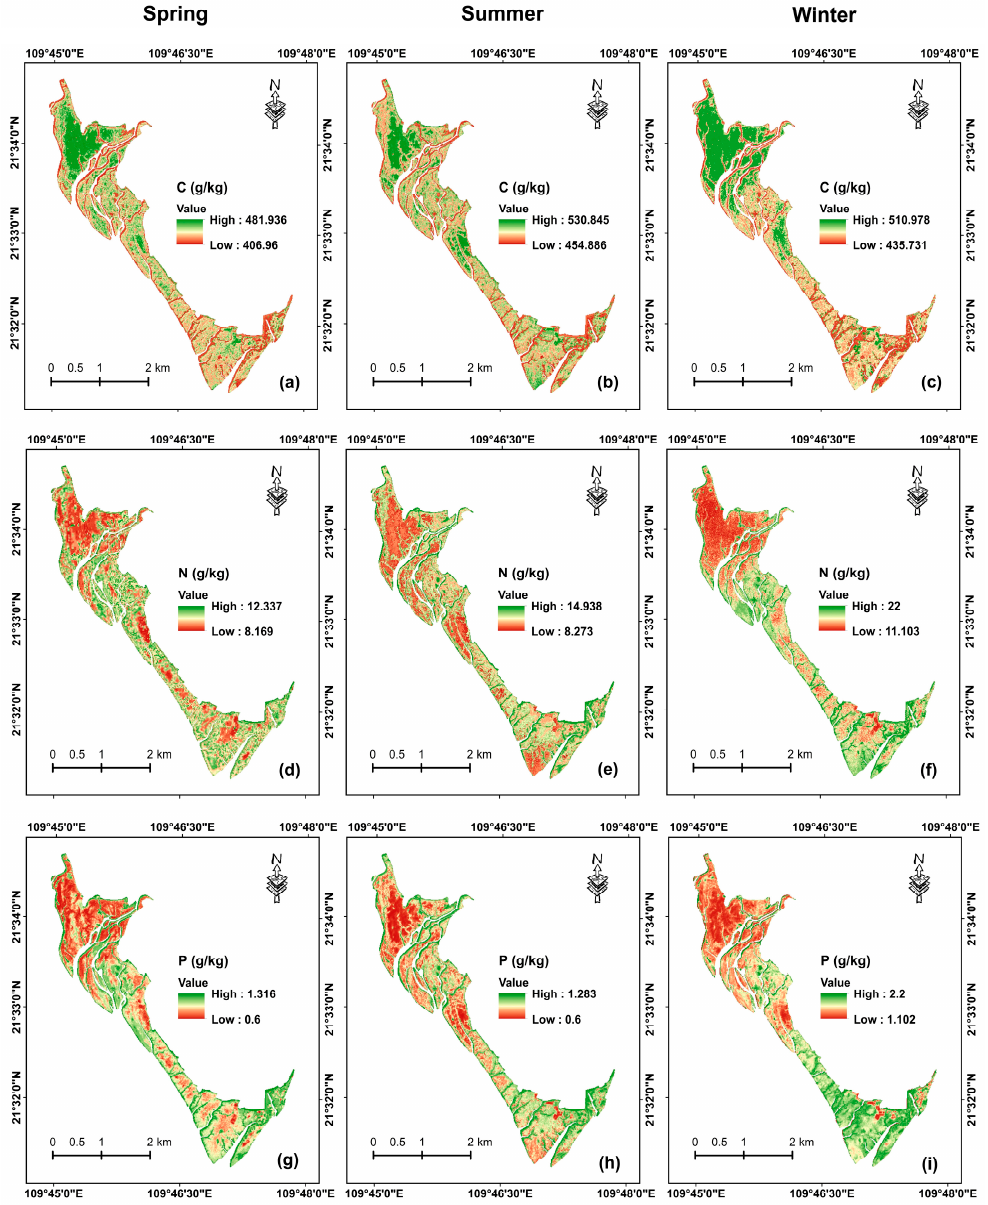
Figure 6. Maps of leaf C ( a – c ), N ( d – f ), and P ( g – i ) concentrations in spring, summer, and winter derived from the XGBoost model using sensitive spectral features of Sentinel-2 images. The mapped N concentrations (mean = 16.937 g/kg, range = 11.103–22.000 g/kg) in winter were higher than those in spring (mean = 9.184 g/kg, range = 8.169–12.337 g/kg) and sum- mer (mean = 9.059 g/kg, range = 8.273–14.938 g/kg). Moreover, the area with higher C was found to have lower N. The mapped leaf P concentrations showed similar spatial distribution characteristics to the mapped N concentrations, and leaf P showed higher concentrations in winter (mean = 1.513 g/kg, range = 1.102–2.200 g/kg) than in spring (mean = 0.832 g/kg, range = 0.600–1.316 g/kg) and summer (mean = 0.773, range = 0.600–1.283